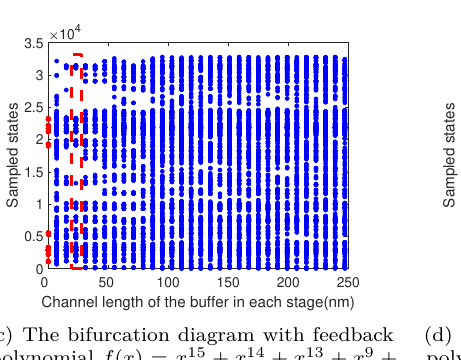
x 9 + x 3 + x 2 + 1. Figure 17: The simulated bifurcation diagrams corresponding to the example feedback polynomials in the rules, where the states without and with extra delays are marked with red and blue dots respectively, and the red dashed rectangles highlight the recurrence of periodic